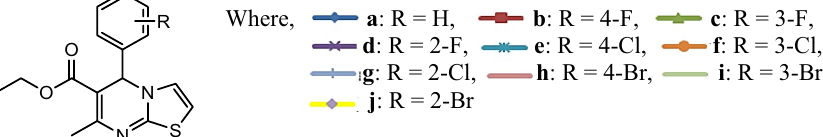
Figure 1. Phytotoxic effect of thiazolo[3,2-a]pyrimidine carboxylate derivatives at 500 mg/L on green pigment degradation of Oldenlandia verticillata throughout seven days of incubation period. Each score representing different colour retention of leaf disc. Score 1: Green—The leaf disc surface is completely green; Score 2: Green brownish—10–30% of leaf disc surface is dark brown in colour; Score 3: Brown greenish—50–80% of leaf disc surface is dark brown in colour; Score 4: Dark brown—More than 90% of leaf disc surface, in aggregate, is dark